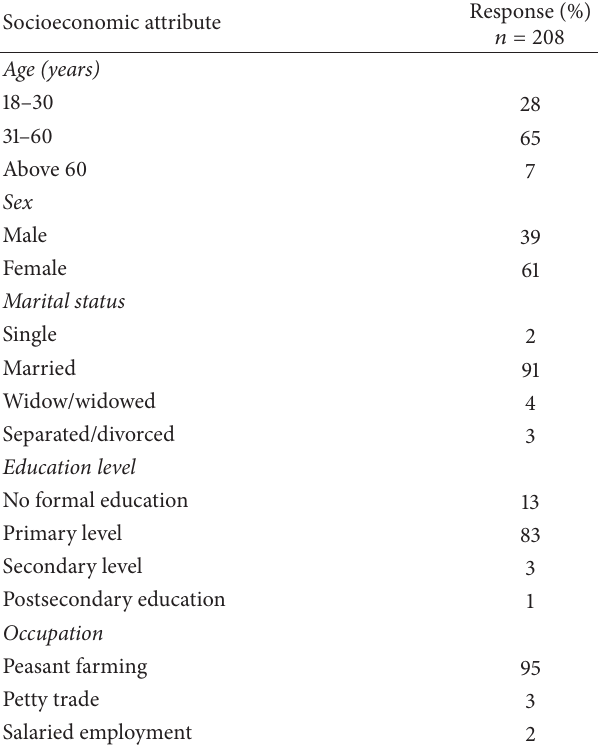
Table 3: Socioeconomic characteristics of the respondents in the study